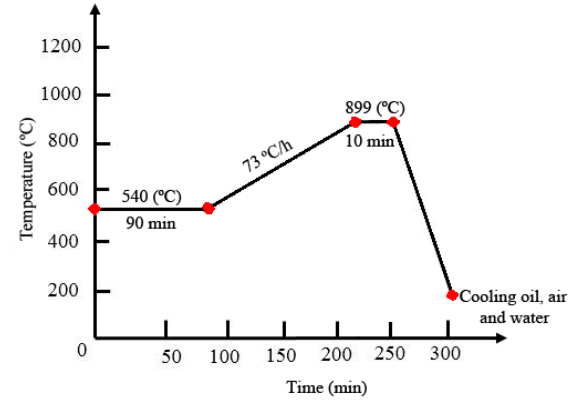
Figure 2. Micro-hardness indenters (Vickers) in width and depth.